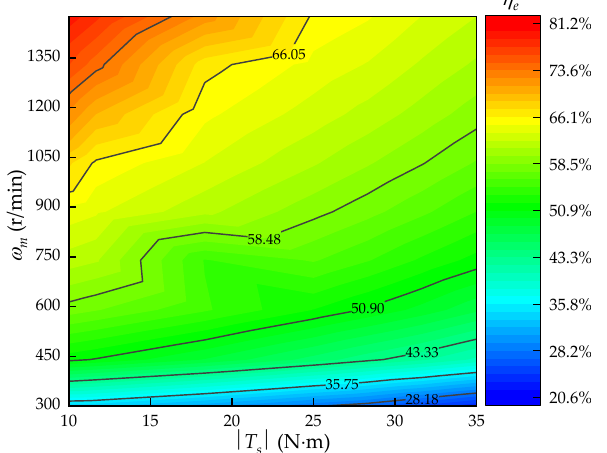
Figure 12. Power-saving ratio map for EPCBV compared with T-CBV systems.